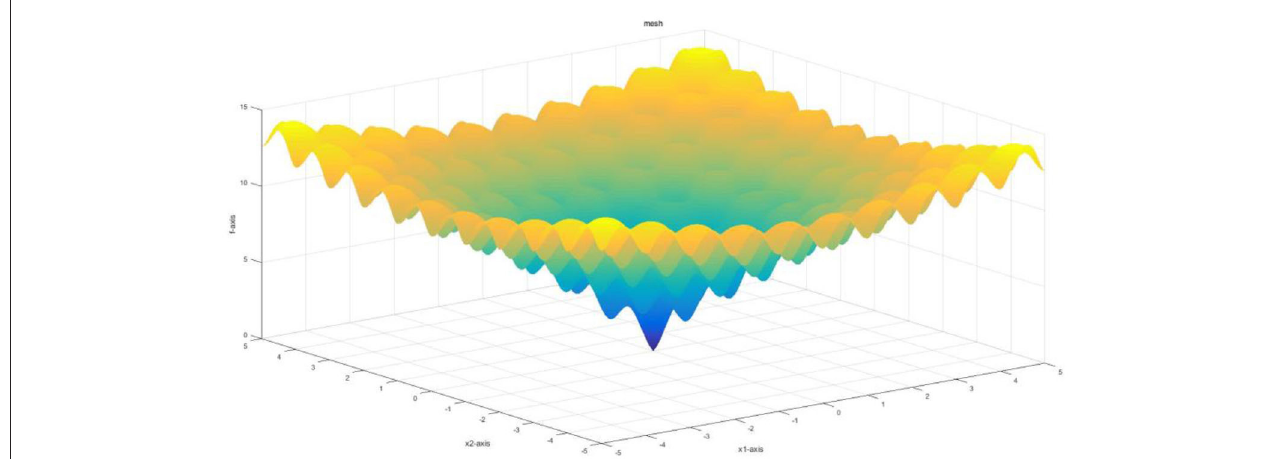
FIGURE 3 | The image of the Ackely